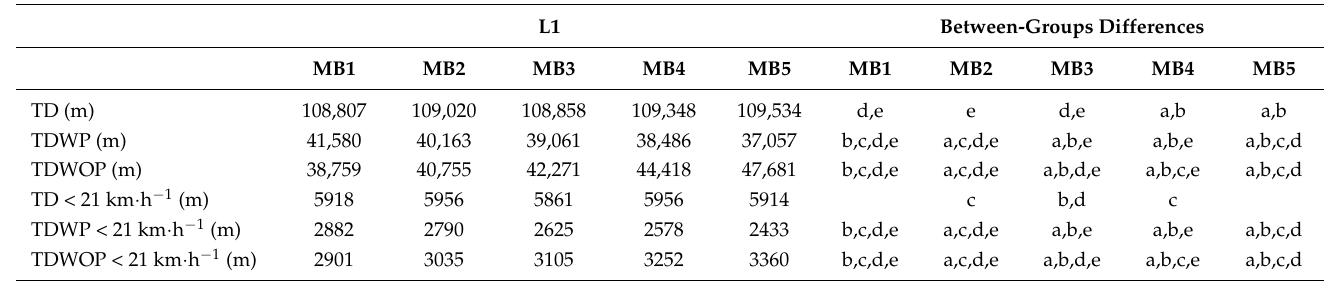
Table 1. Movement profiles based on quality of the opponent in LaLiga Santander.